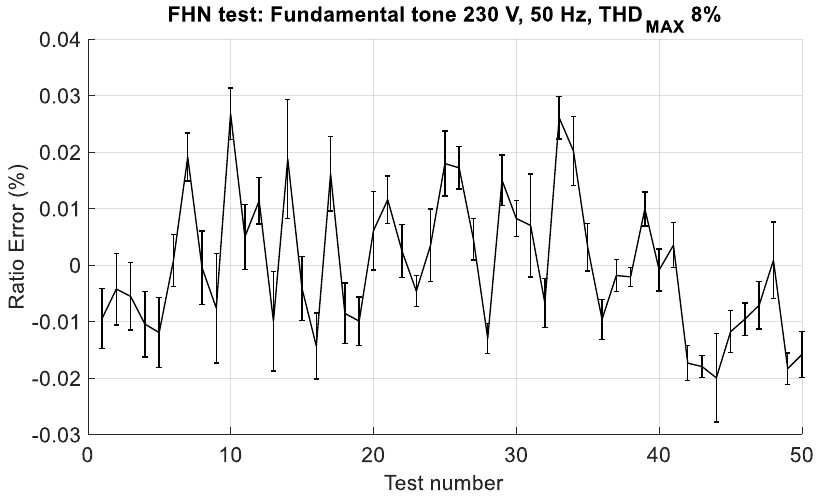
Figure 17. Ratio error in the FHN tests; waveforms are composed of a fundamental tone, with amplitude